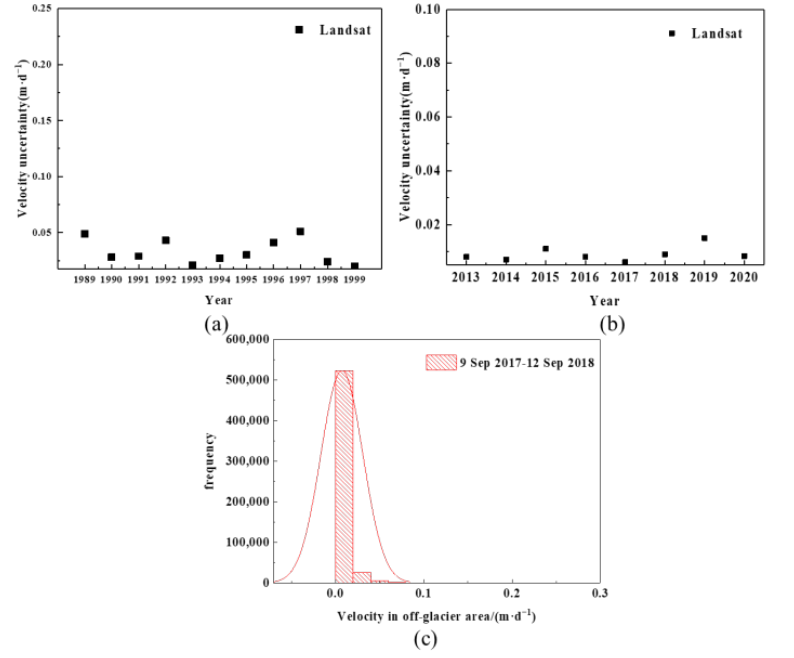
Figure 3. Off-glacier area error. ( a , b ) Glacier velocity uncertainty between pairs of Landsat images; ( c ) example of the velocity distribution in an off-glacier area.